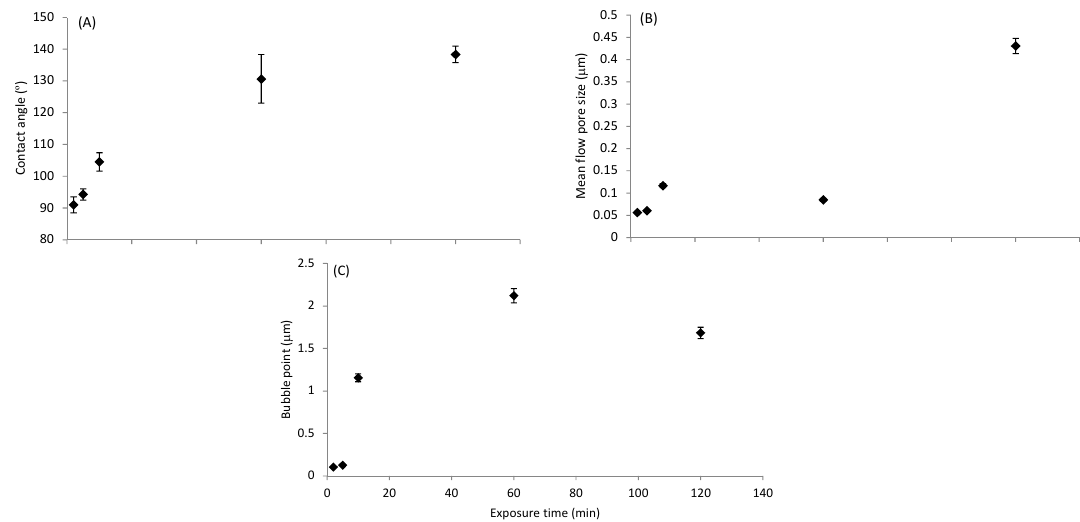
Figure 7. Impact of exposure time on ( A ) CA (contact angle); ( B ) MPS (mean flow pore size) and ( C ) BP (bubble ‐ point pore size), for membranes prepared under RH of 60% and at casting thickness of 500 μ m with 12% w / w PVDF concentration.